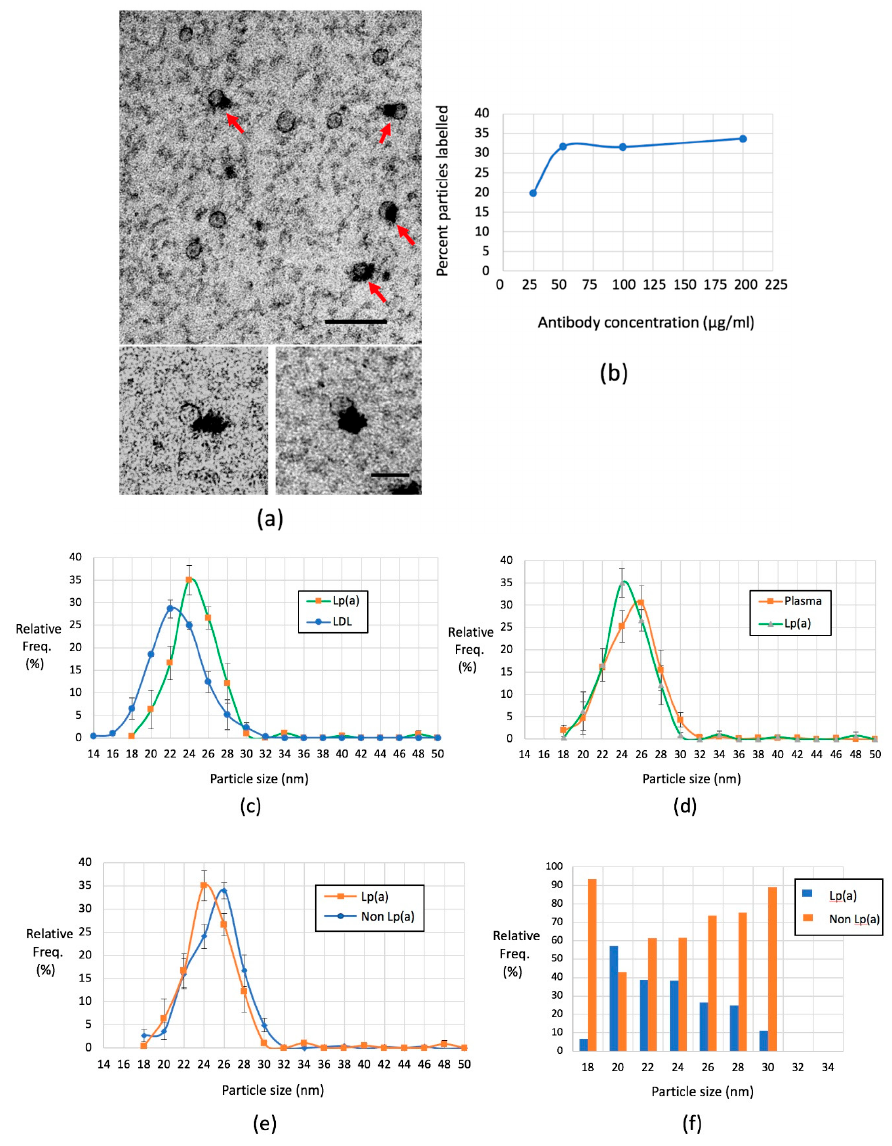
Figure 7. Lp(a) LPs identified using anti-apolipoprotein(a) antibodies. Human plasma adsorbed to EM supports and exposed to polyclonal anti-apolipoprotein(a) antibodies produce densities (arrows) associated with a subpopulation of LPs (( a ) with details illustrated in two bottom panels; scale bars 100 nm and 50 nm, respectively). ( b ) The percentage of apolipoprotein(a)-positive particles plateaued with increasing antibody concentration. Frequency distribution of apolipoprotein(a)-positive particle sizes compared to purified human LDL ( c ); human plasma ( d ) and non-Lp(a) particles ( e ). ( f ) shows the percentage of total particles at each size category that are positive or negative for apolipoprotein ( a ). Error bars are SD from three experiments from the same sample of human plasma. >100 particles sampled in each case. In ( c ), ( d ) and ( e ), data represents the relative frequency of particle number for each particle size category expressed as a percentage of total particles analyzed (Relative Freq. %). In ( f ), Relative Freq. % represents the percentage of total particles found in each size category that were positive or negative for Lp(a).